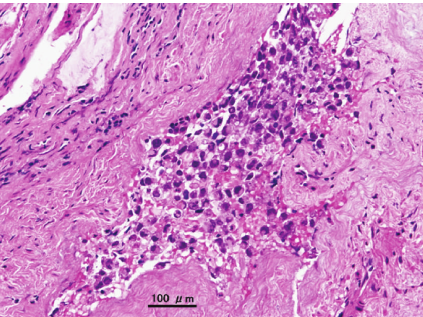
Figure 3: Pathological findings. Amorphous medullary prolifera- tion of medium-sized circular atypical cells is apparent. Nuclei are deeply stained, many are eccentrically located, cytoplasm is lightly eosinophilic, and some cells show brown pigment in